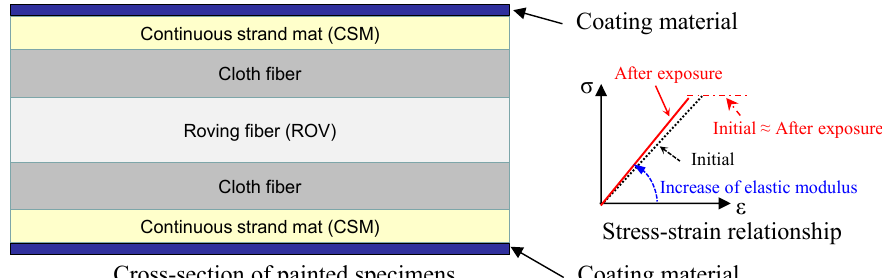
Figure 6. Summary of results of painted specimens.